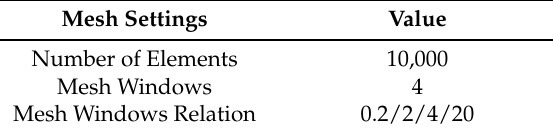
Table 2. New mesh